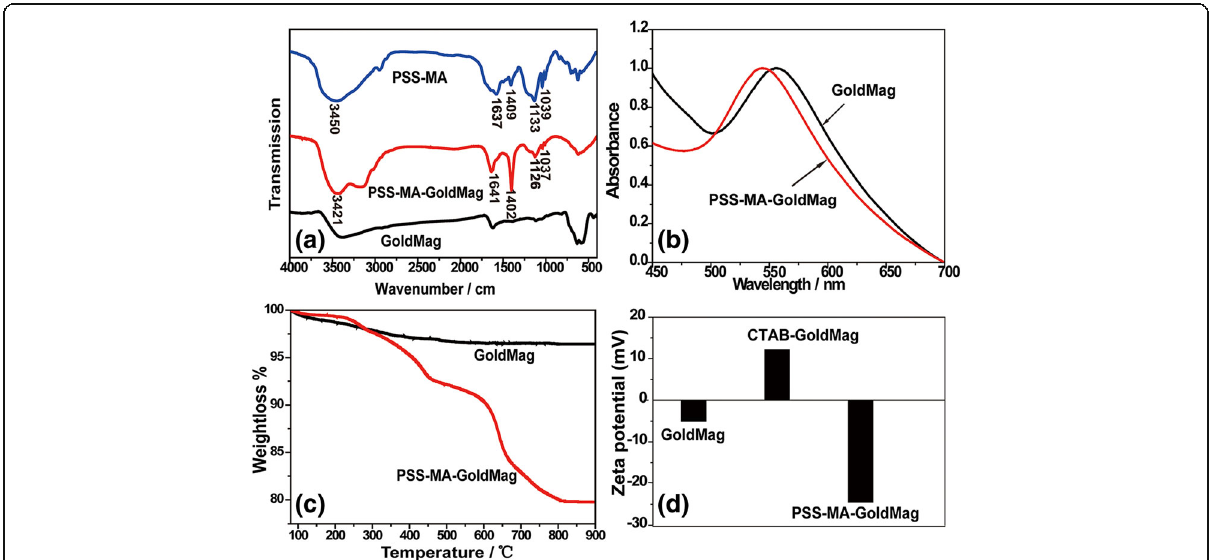
Fig. 1 a FTIR spectroscopy of PSS-MA, PSS-MA-GoldMag, and GoldMag. b SPR spectroscopy of GoldMag and PSS-MA-GoldMag suspended in water. c TGA analysis of GoldMag and PSS-MA-GoldMag. d The change of zeta potential as a result of the modification